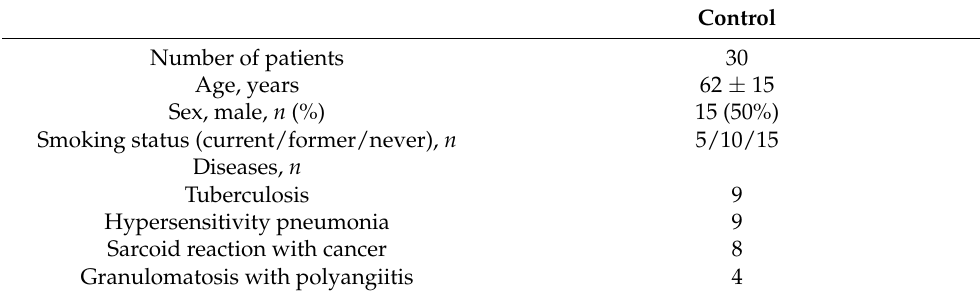
Table 2. Baseline characteristics of control patients with other granulomatous